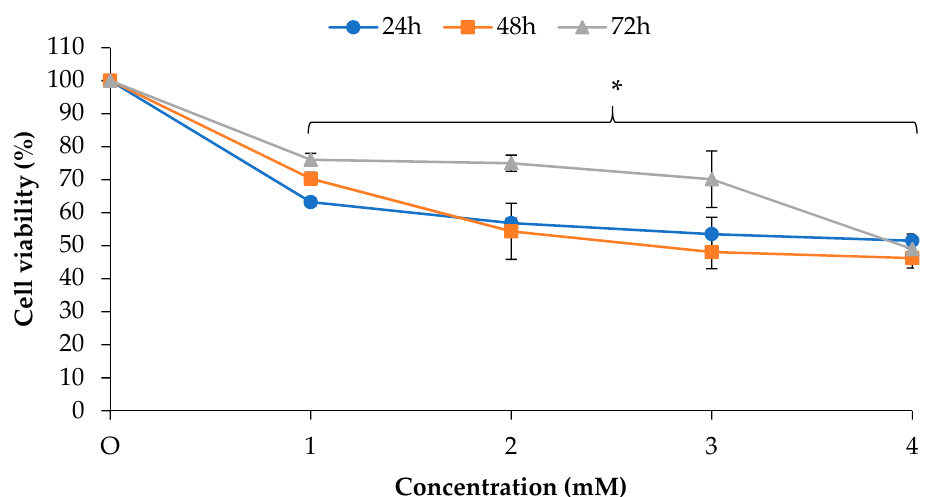
Figure 2. Anti-proliferative effect of 2-DG in PANC-1 cells. PANC-1 cells were treated with 1–4 mM of 2-DG for 24, 48 and 72 h. The anti-proliferative effect was measured by MTT assay. The data were shown as the mean values ± S.D. for three independent experiments, and the statistical analysis was determined using a Student’s t -test, with the * symbol showing a significant difference ( p < 0.05) in comparison to control untreated cells.